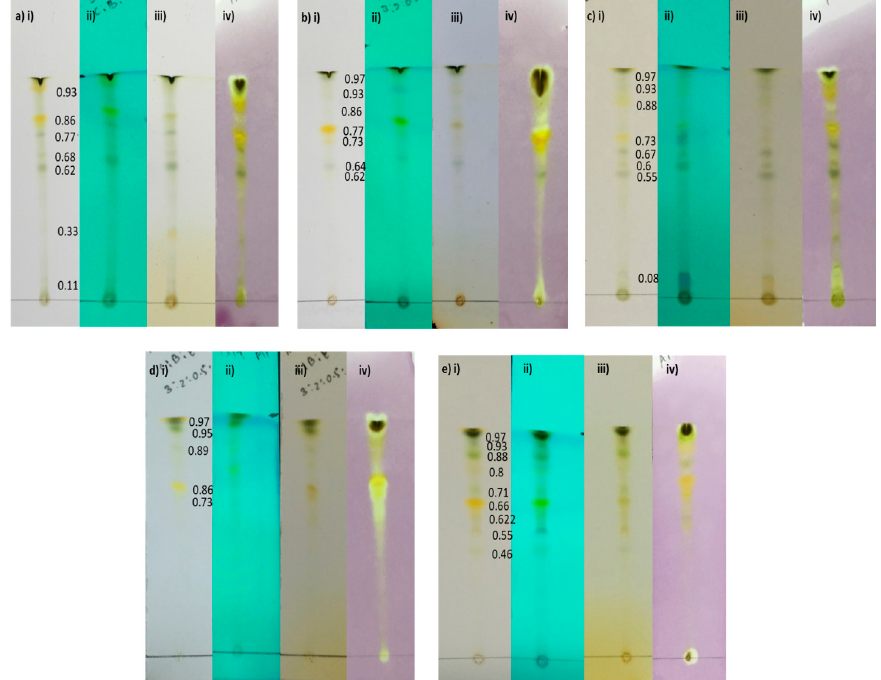
Fig. 1. TLC and TLC DPPH Bio-autography results of chloroform extracts of a) Phyllanthus acidus , b) Piper aduncum, c) Pandanus amaryllifolius, d) Macaranga peltata, e) Acacia mangium. i) Visible light ii) UV iii) Iodine vapour and iv) DPPH